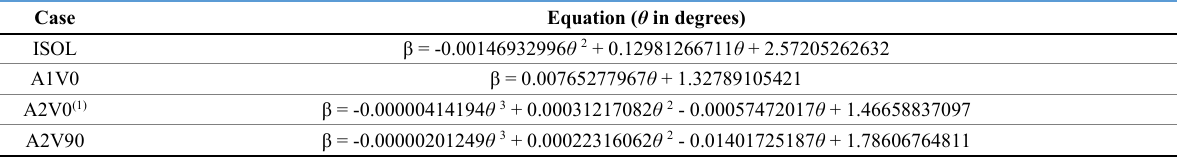
Table 2. Equations of β for acceleration at the top, x-direction – limit criterion of 8.4 cm/s 2 .